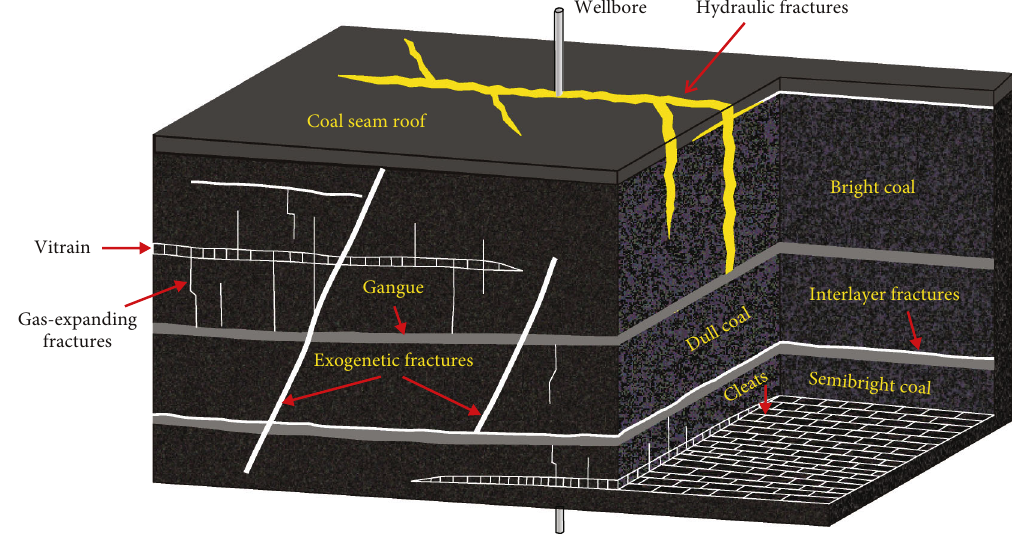
Figure 3: Sketch of the VFS in coal Table 1: VFS classi fi cation in coal seams.